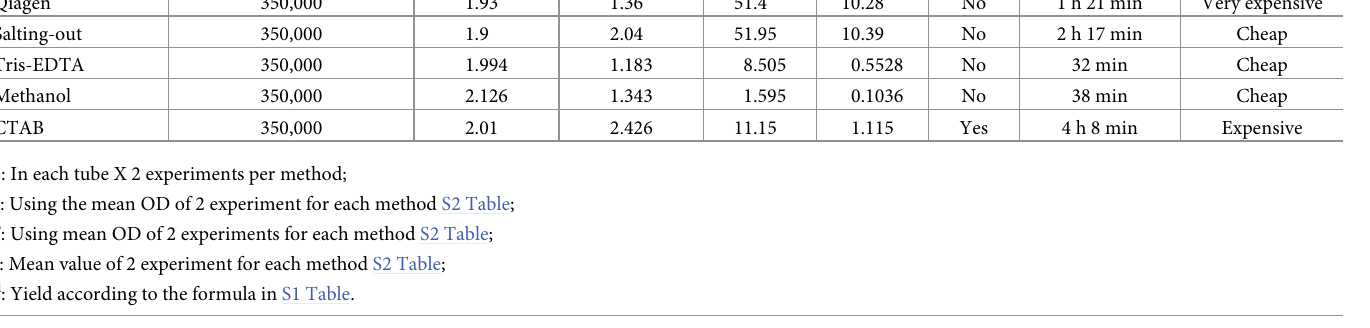
tively). The highest 260/230 ratio was obtained with salting-out and CTAB (2.04 and 2.426,